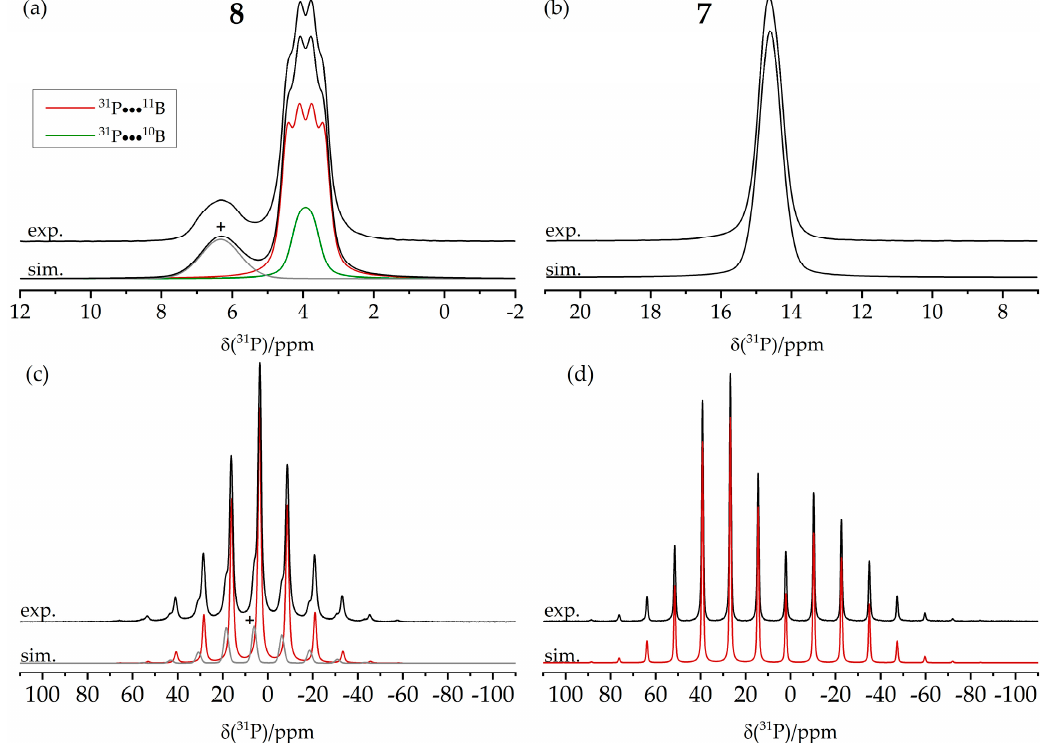
Figure 27. Experimental and simulated 31 P{ 1 H} CP/MAS NMR spectra of 8 and 7 measured at 7.05 T and MAS frequencies of ( a , b ) 12.5 kHz and ( c , d ) 3.0 kHz. Note the significant differences in the